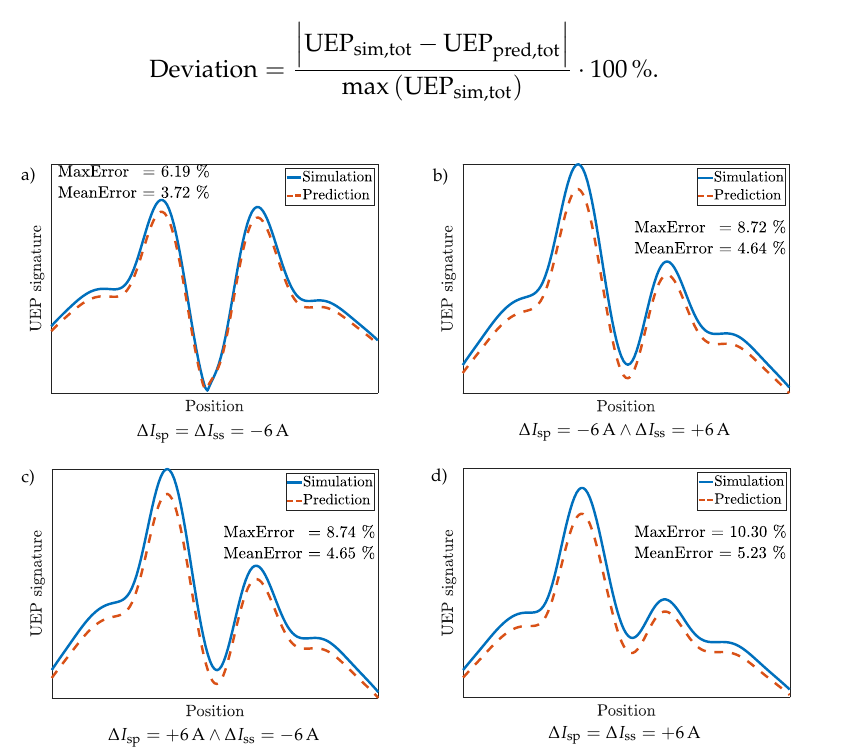
Figure 6. Scenario 1 (Hy-80 steel hull): prediction example of the magnitude of the UEP signature for changing the impressed currents (subfigure ( a – d )) of the ICCP electrodes at the stern using the prediction formulae from the Equations (8)–(10) and the polarization curve of the HY-80 steel for the hull and sea chests. The difference of the impressed current of the portside electrode ∆ I sp and the starboard electrode ∆ I ss represent the adjustment of the ICCP currents in correspondence to the reference ICCP currents at said electrode for corrosion protection. With a maximum deviation of approximately 10% in ( d ) the prediction accuracy can be defined as